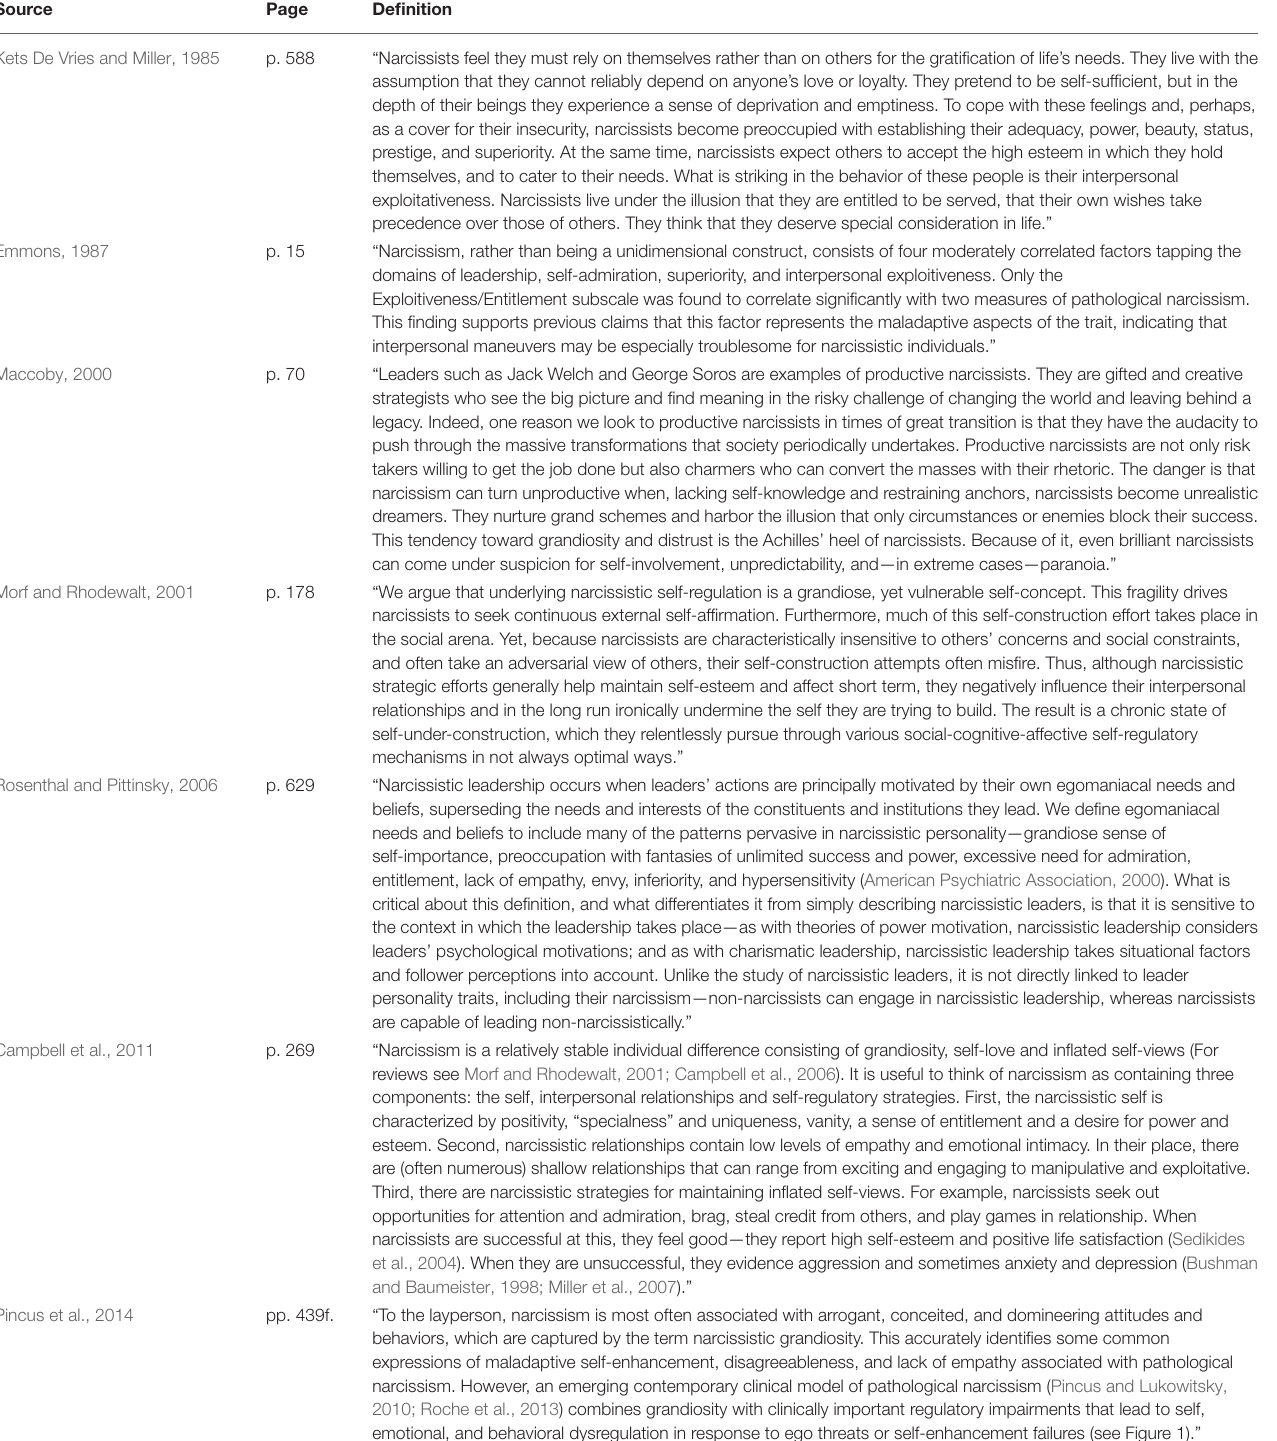
TABLE 1 | Overview of influential narcissism